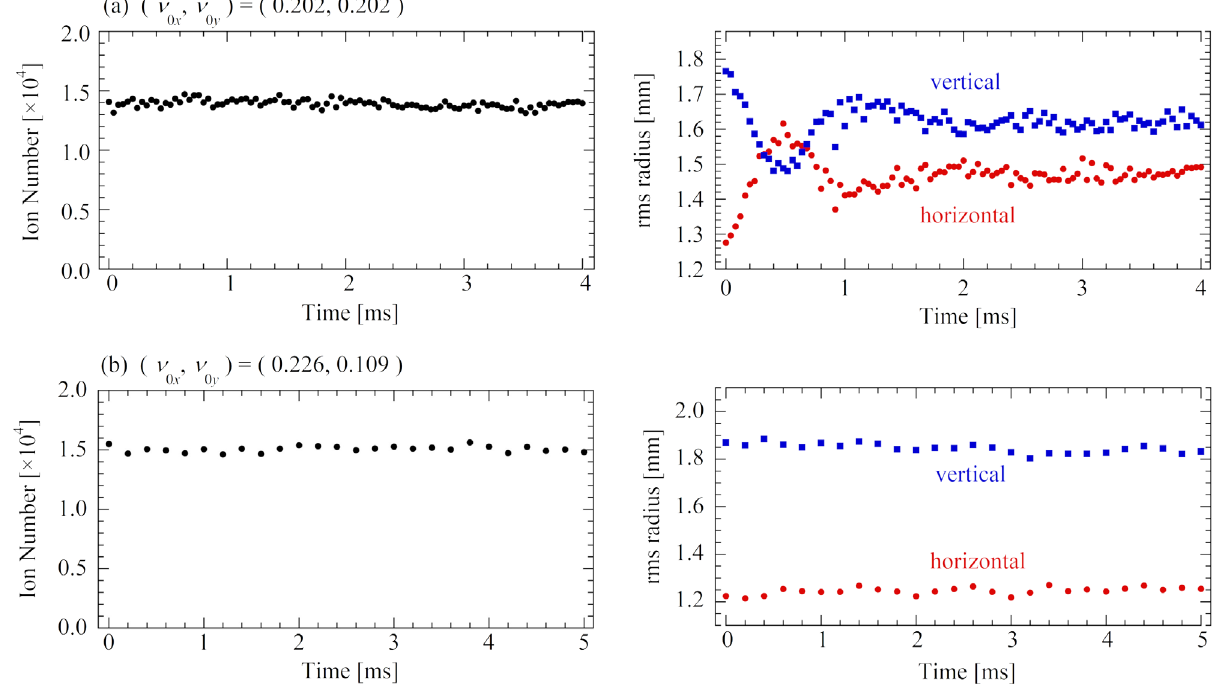
FIG. 25. Time evolution of the ion number (left) and transverse plasma extent (right) measured in S-POD. The ion plasma used for this experiment is initially anisotropic. The operating point of the LPT is adjusted to: (a) ð ν 0 x ; ν 0 y Þ ¼ ð 0 . 202 ; 0 . 202 Þ , and (b) ð ν 0 x ; ν 0 y Þ ¼ ð 0 . 226 ; 0 . 109 Þ